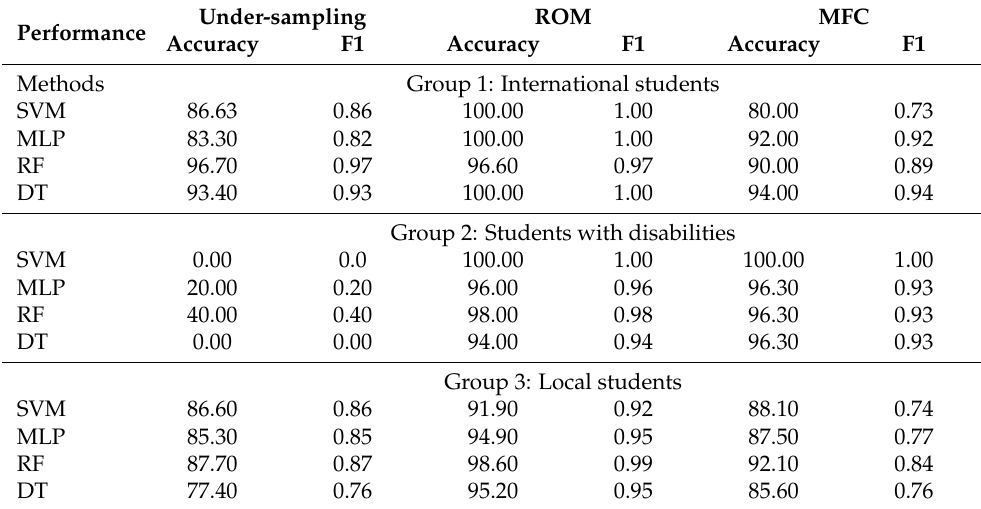
Table 8. Comparison of re-sampling techniques (under-sampling and ROM).